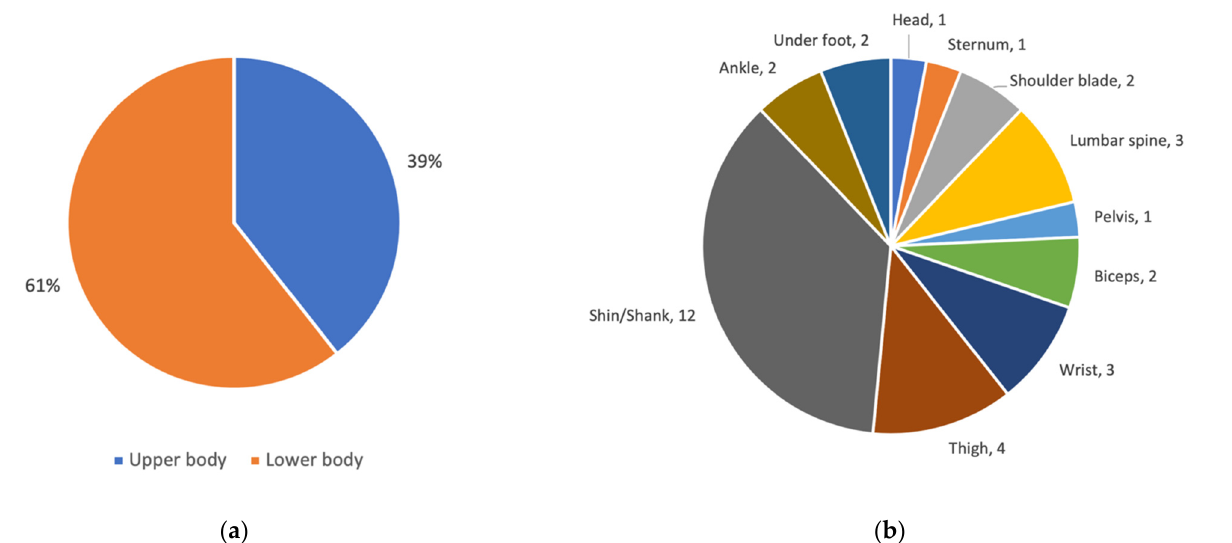
Figure 7. Information on sensor locations for articles in Tables 5 and 6, i.e., the articles using classification methods/models with or without machine learning algorithms: ( a ) Distribution of sensors located at the upper or lower body; ( b ) Number of sensors per body location.